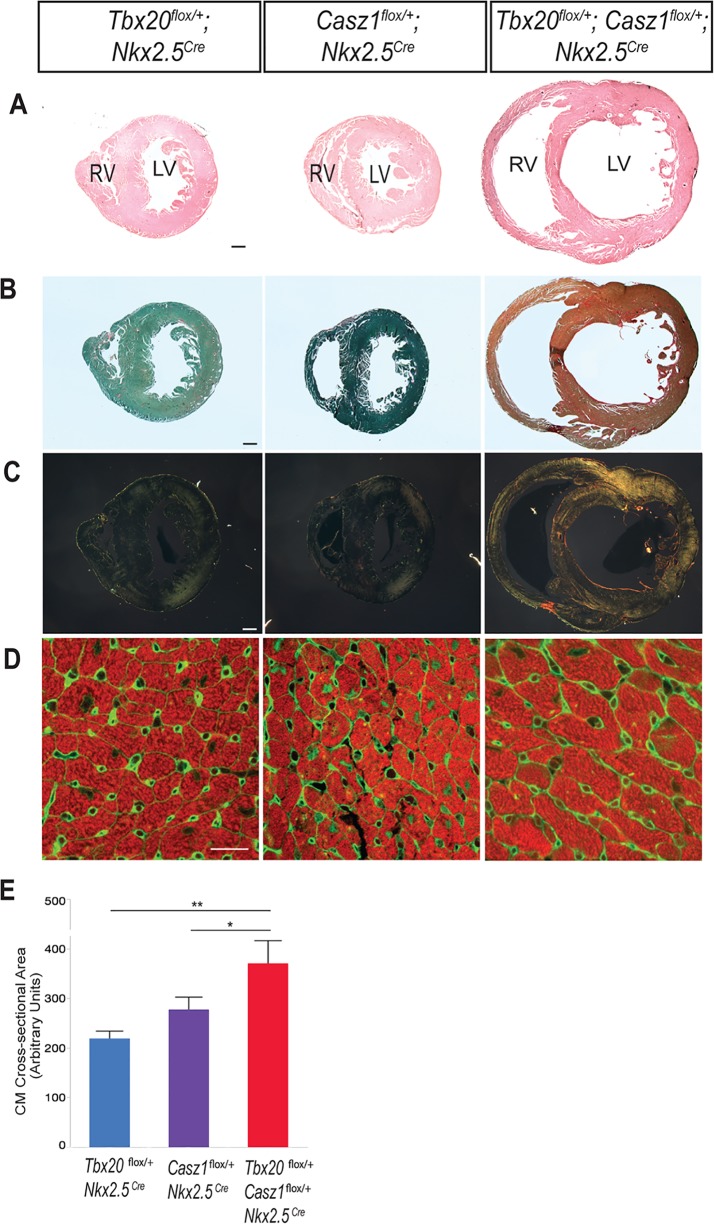
Double heterozygous hearts undergo pathological remodeling.(A-D) Hearts from mice aged 8–11 weeks. (A) Transverse sections of hearts stained with hematoxylin and counter-stained with eosin. (B) Transverse sections of hearts stained with Picrosirius red and fast green, and visualized using bright field microscopy. (C) Polarizing light microscopy of Picrosirius red-stained sections. Thin collagen fibers stain green to yellow, while thicker collagen fibers stain orange to red. (D) Transverse heart sections were immunostained with tropomyosin (red, cardiomyocytes) and WGA (green, cell membranes). Region of left ventricular free wall shown. (E) Quantification of cardiomyocyte cross-sectional areas, shown as mean ± SEM of 450+ cardiomyocytes per heart, n = 3 hearts per genotype. *p<0.05, **p<0.0005. Statistical significance between pairs was calculated using Student’s t-test. A-C, scale bar = 300 μm. D, scale bar = 20 μm.